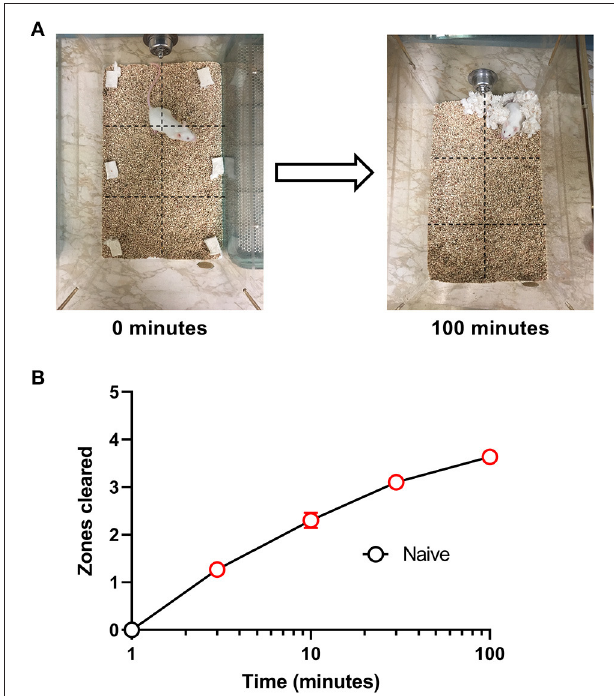
FIGURE 1 | Nesting in naïve mice. (A) Representative images of nesting behavior at time 0min and at the end of the experiment at 100min. Nestlets were placed within the cage in six equally sized zones indicated by the dotted grid lines, and the number of zones cleared of their nestlet was determined at 1, 3, 10, 30, and 100min. The maximum number of zones that can be cleared is 5. (B) Nestlet consolidation can be quantified as a time-dependent increase in zones cleared. Red points indicate significance ( P < 0.05) vs. “time = 1 min” by repeated measures one-way ANOVA with Dunnett’s test. Data are mean ± SEM. N = 30 for every time point.